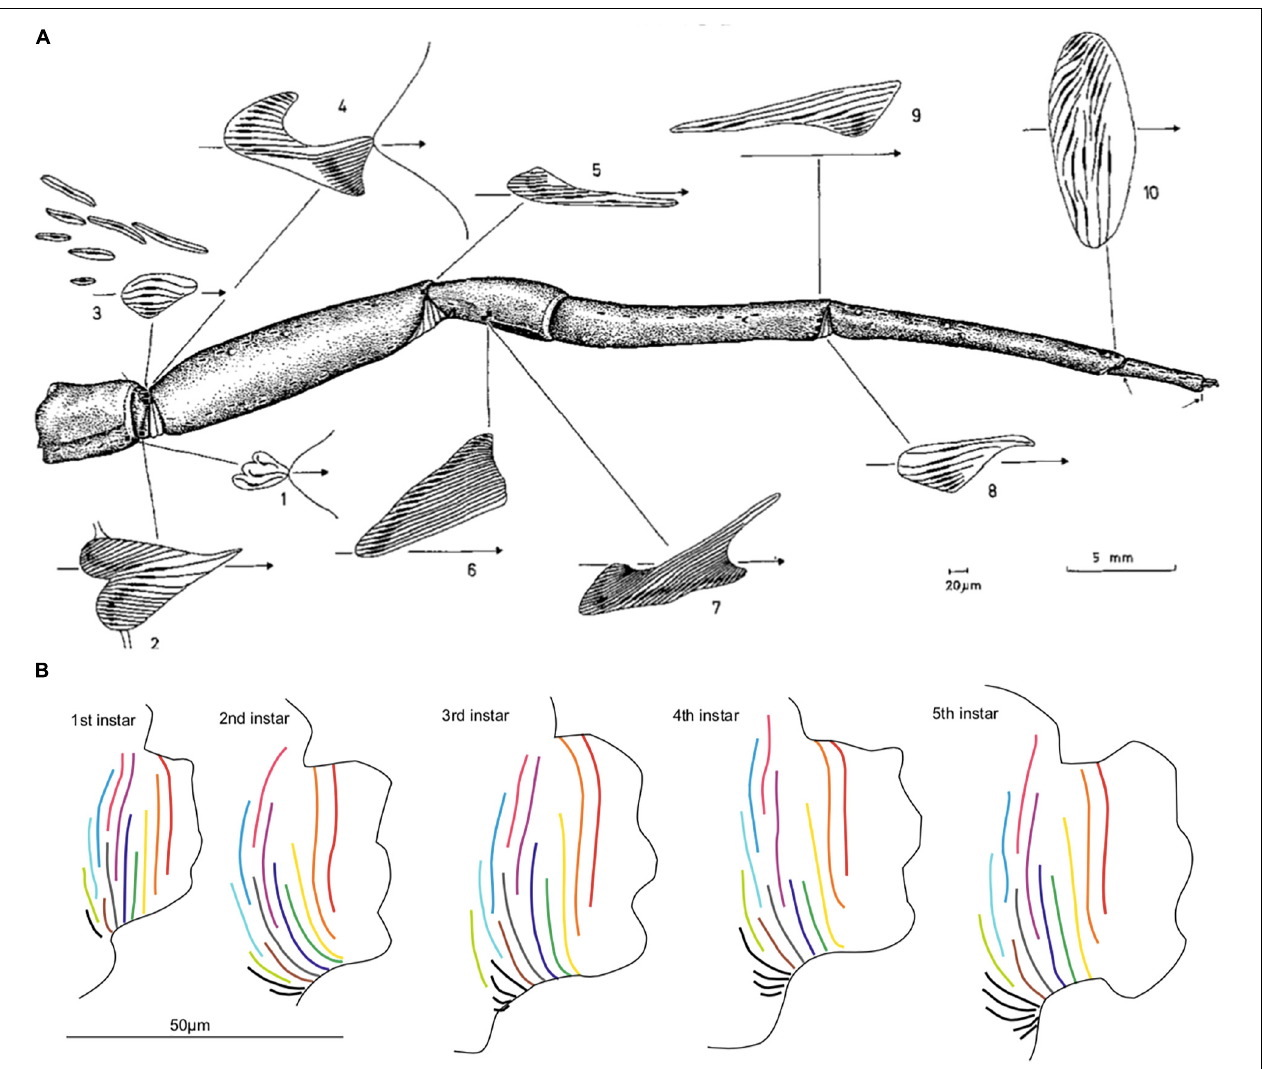
FIGURE 3 | A —spatial variation in lyriform organ geometry on the posterior of the first leg of Cupiennius salei , including heart-shaped, triangular, oval and irregular arrangements of slits. B —temporal variation in the HS10 lyriform organ on the first leg over the first 5 juvenile instars of Latrodectus hesperus , demonstrating changes in shape as well as increase in overall number of slits through growth. (A) Reprinted by permission from Springer Nature Copyright Clearance Centre: Springer Nature, Zoomorphologie (Slit sense-organs of arachnids - Comparative-study of their topography on walking legs ( Chelicerata. Arachnida ), Barth, F. G. and Stagl, J.) [Copyright], (1976). (B) Reprinted by permission from Springer Nature Copyright Clearance Centre: Springer Nature, Zoomorphology (Developmental morphology of a lyriform organ in the Western black widow ( Latrodectus hesperus ), Morley, E. L., et al.) [Copyright],